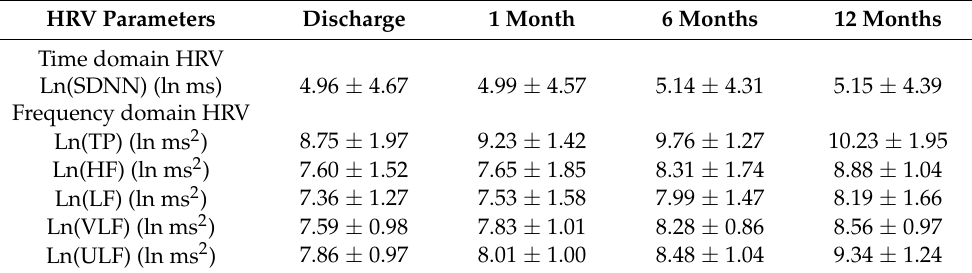
Table 2. The time- and frequency-domain HRV parameters during the follow-up periods.